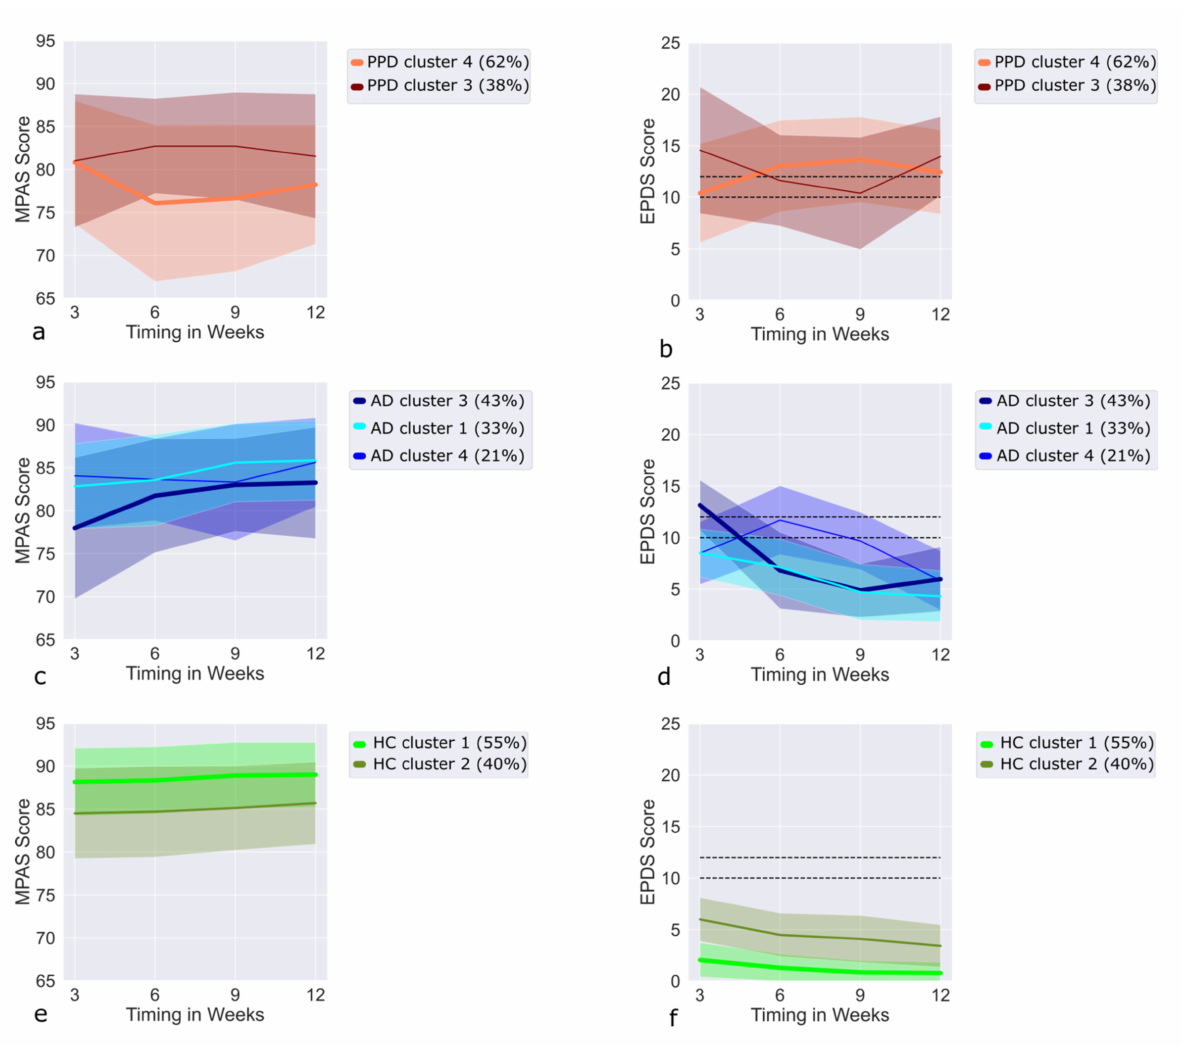
Figure 3. MPAS and EPDS trajectories for every diagnosis outcome, based on the latent clusters, acquired from the multlcmm clustering for: ( a , b ) PPD patients; ( c , d ) AD patients; ( e , f ) healthy women. Percentages next to clusters show the percentage of the cluster in each diagnosis. Abbreviations: PPD, postpartum depression; AD, postpartum adjustment disorder; HC, healthy